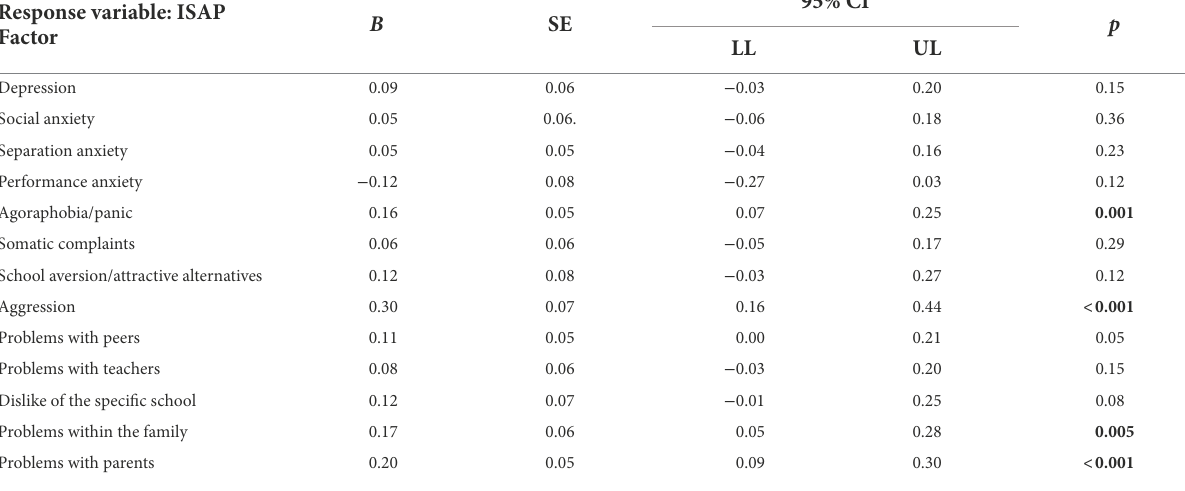
TABLE 4 Comparison of the symptoms (ISAP S) between adolescents with ADHD and neurotypical adolescents per ISAP Factor in multivariate analyses.